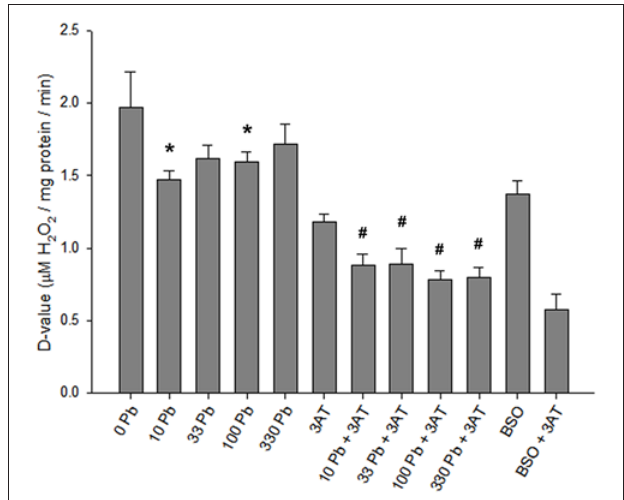
FIGURE 4 | D -values for H 2 O 2 clearance in rat astrocyte cultures. Standardized H 2 O 2 clearance values were derived from H 2 O 2 half-times. The higher the D -values, the faster the rate of detoxification. Incubation conditions were the same as in Figure 3 . Treatment concentrations: 1 mM BSO, 10 mM 3AT; concentrations for lead (Pb) are in µ M. Statistical analyses were performed on lead-treated conditions. Significant differences ( p < 0.05) between lead-treated and untreated control are represented by ∗ . Significant differences ( p < 0.05) between lead + 3AT-treated and 3AT-treated controls are represented by # . Each bar represents a mean ± SD of n = 9 samples, except for those treated with 10 µ M lead where n = 6.